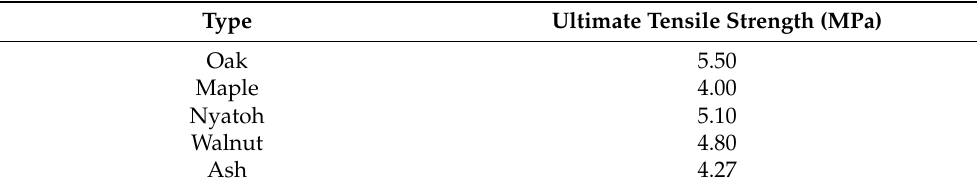
Table 7. Ultimate tensile strength of each type of wood.